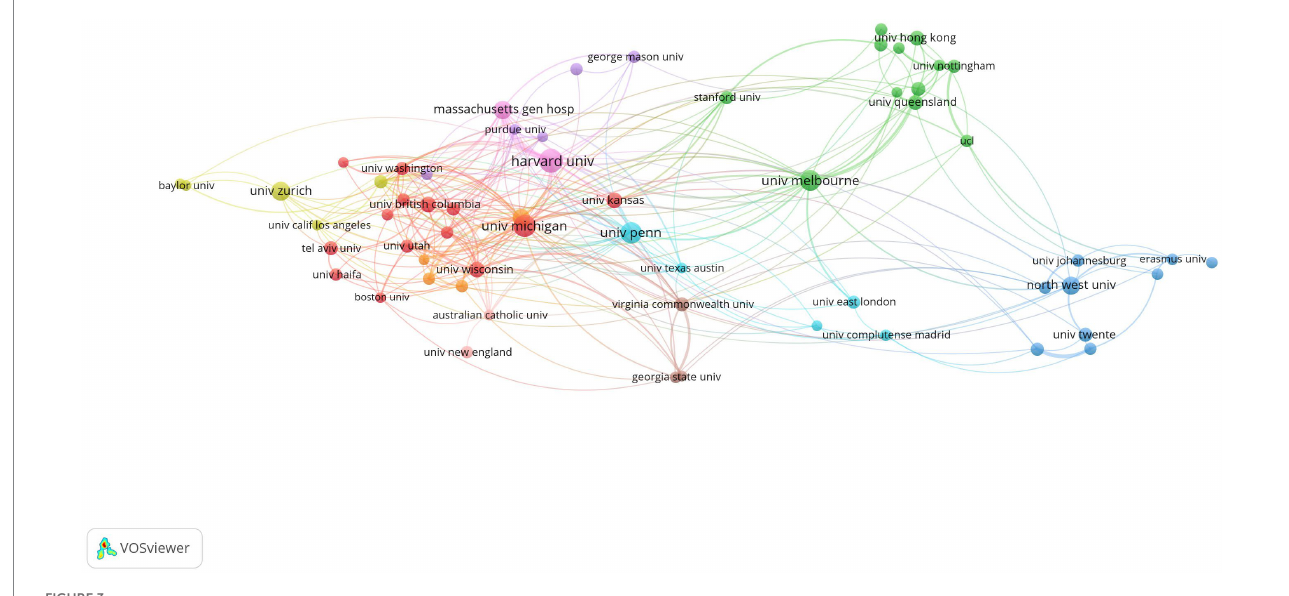
FIGURE 3 Map of institutions in positive psychology research.